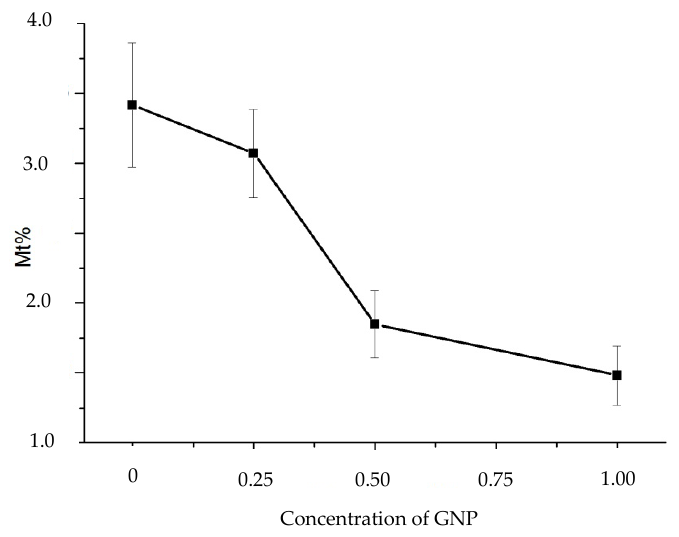
Figure 21. Change in Mt% mass at day 21 of aging in KCl for the resin and the three composites at different GNP concentration.